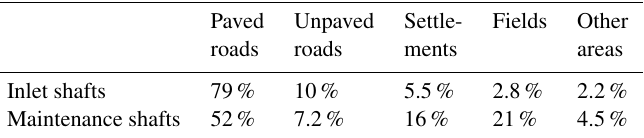
Table 4. Percentage of shafts found in a certain type of landscape element. The category of other areas integrates several types of landscape elements, including railways, other traffic areas, forests, water bodies, wetlands, and single buildings. Paved Unpaved Settle- Fields Other roads roads ments